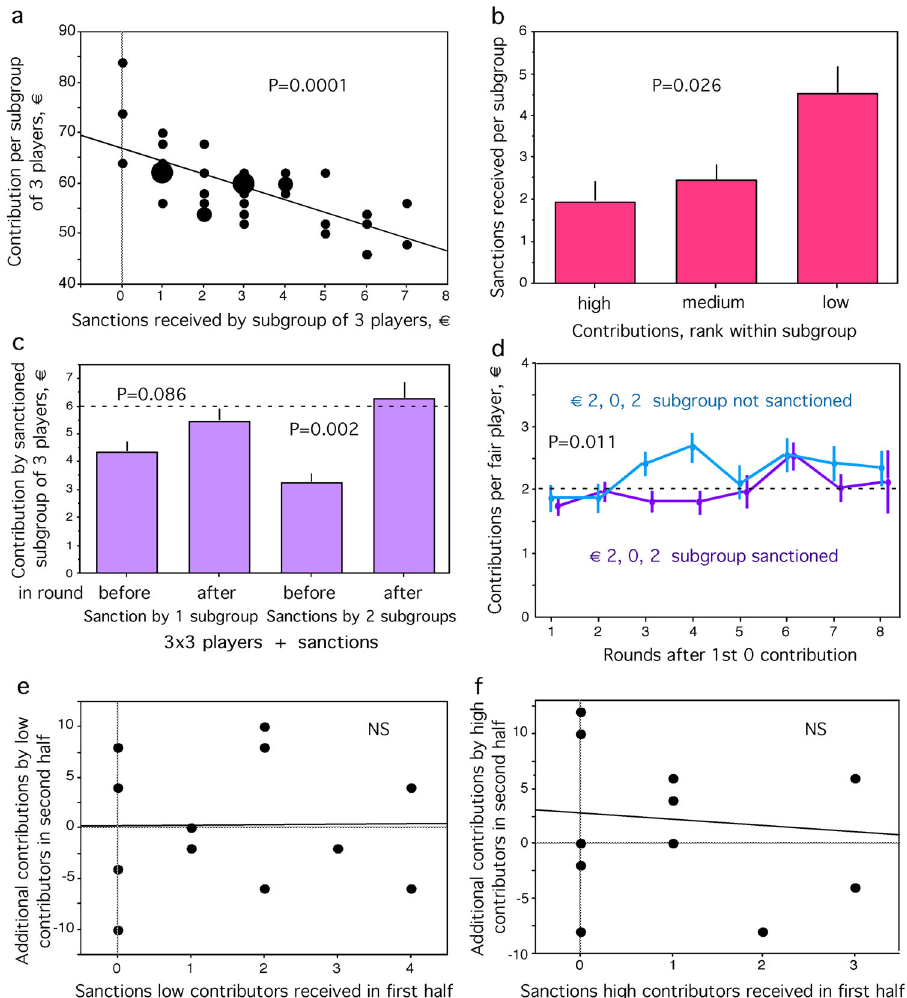
Fig. 4 The effect of sanctions. a Regression of sanctions received by subgroups of 3 players on the total contribution of subgroup. Bigger dots indicate overlay. b Sanctions received per subgroup whose total contribution ranks either high, medium or low within its group. c Mean contribution by sanctioned subgroup in round before and after sanctioning by one or two subgroups, respectively. Bars indicate standard errors. Stippled line indicates the fair contribution per subgroup. d Contribution per player that had contributed € 2 when the subgroup was sanctioned because another player had contributed € 0, during rounds after the sanctioning was received (T3, pink); only fi rst instance of sanctioning per subgroup analysed. The same analysis carried out in the treatment for the fi rst occurring triplet of € 0, € 2, € 2 contributions (T4, blue). Bars indicate standard errors. Stippled line indicates fair share per player. e Regression of sanctioned players with the lowest contribution rank in a subgroup received during the fi rst 5 rounds on their additional contributions during the last 5 rounds of the experiment. f Regression of sanctioned players with the highest contribution rank in a subgroup received during the fi rst 5 rounds on their additional contributions during the last 5 rounds of the experiment. See text for